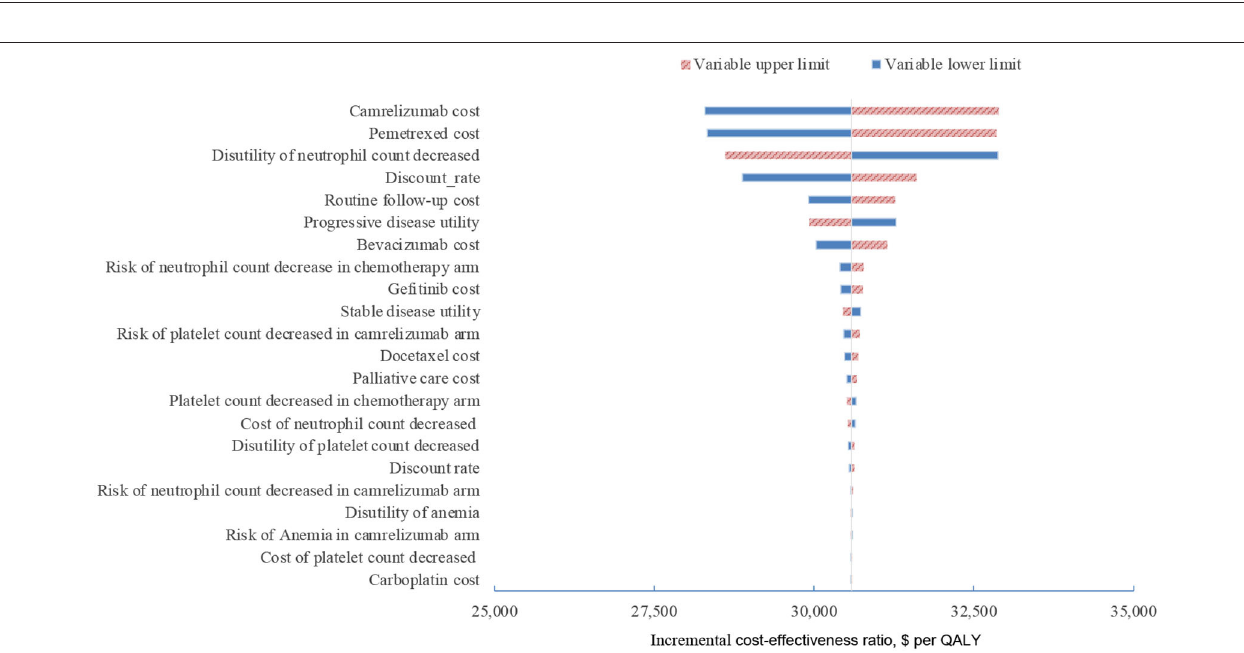
FIGURE 3 | Deterministic sensitivity analysis for the scenario analysis. QALY, quality-adjusted life-years.